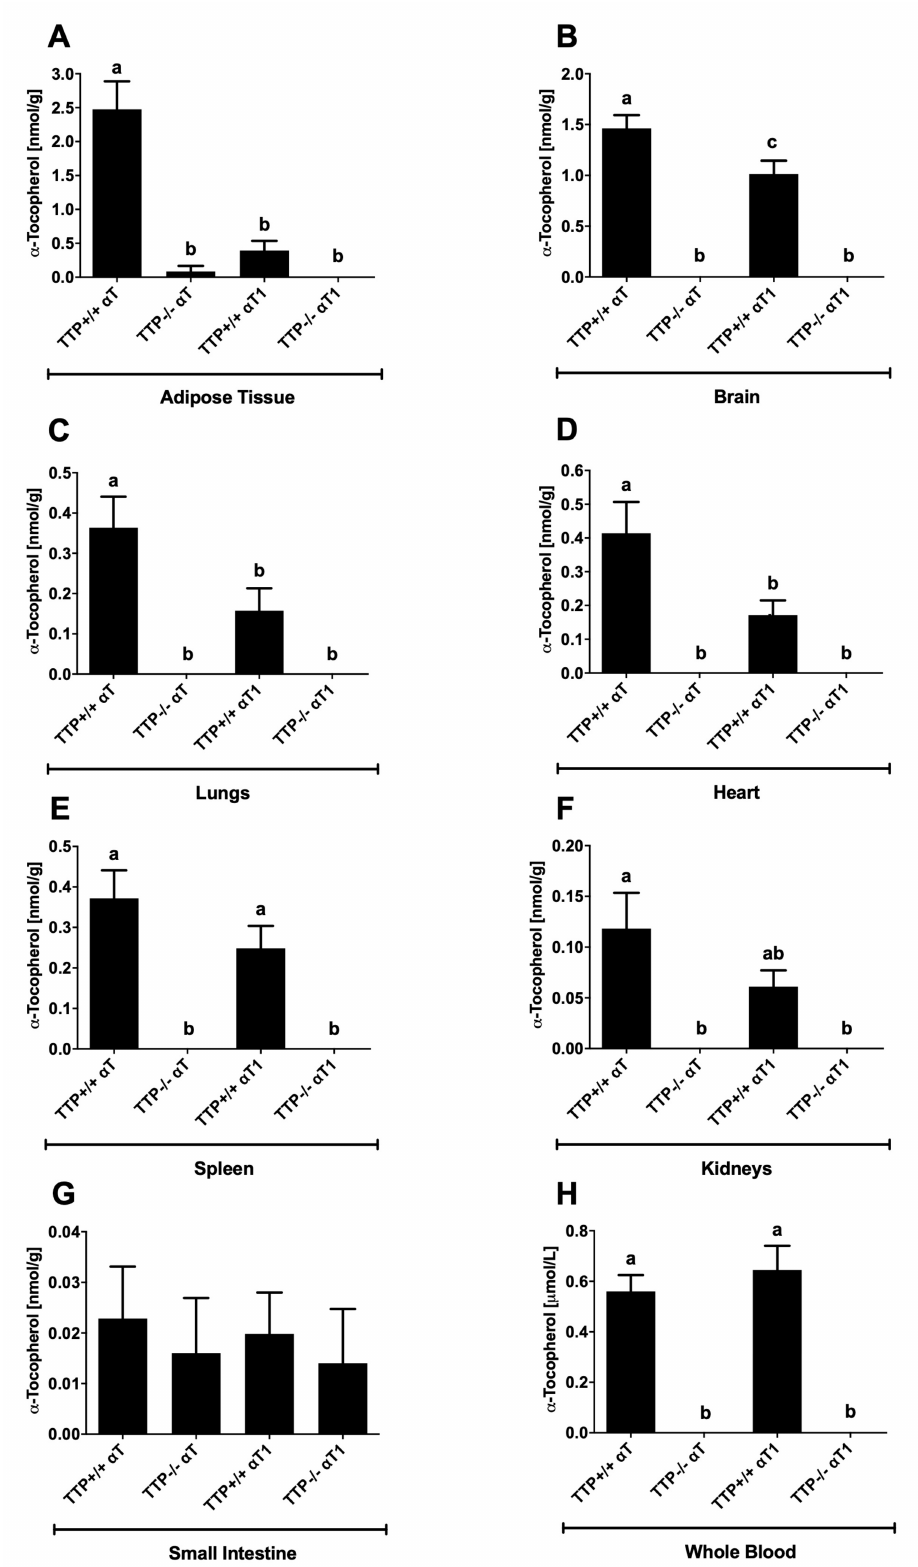
Figure 4. Mean tissue concentrations (error bars represent standard error of the mean; n = 11) of α -tocopherol ( α T) in ( A ) adipose tissue, ( B ) brain, ( C ) lung, ( D ) heart, ( E ) spleen, ( F ) kidney, ( G ) small intestine, and ( H ) whole blood of TTP +/+ and TTP − / − mice fed a standard diet with either α T or α -11 (cid:48) -tocomonoenol ( α T 1 ) for 2 weeks. Bars not sharing a common letter are significantly di p <